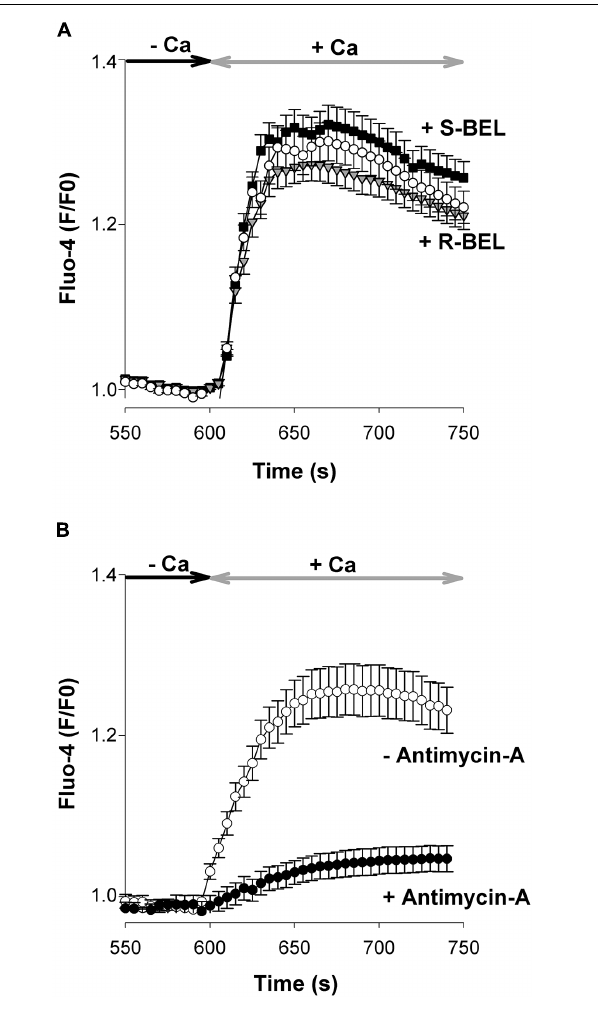
FIGURE 5 | Mitochondria but not iPLA 2 regulate SOCE in cultured cortical neurons. (A) In these experiments cells were pretreated with (S)-BEL (filled squares, n = 144 cells) or (R)-BEL (gray triangles, n = 167 cells; 5 µ M for 30–40 min at 37 ◦ C) before the beginning of the recording. None of these iPLA 2 inhibitors significantly affected the neuronal SOCE. Open circles: control (untreated) neurons. Mean ± SEM. (B) In order to check the contribution of mitochondria in the development of neuronal SOCE, cells kept in a Ca 2 + -free saline were first challenged with Tg (200 nM) that was applied without (open circles, n = 101 cells) or with 5 µ g/mL Antimycin A (filled circles, n = 129 cells). Tg and Antimycin-A were no longer present during the re-admission of Ca 2 + (2 mM). Mean ± SEM. In these graphs only the Fluo-4 signals recorded during the re-admission of external Ca 2 + are shown. inactivation of the SOCs) whereas the resting Ca 2 + entry gave rise to a sustained response ( Figure 6B , filled squares). In